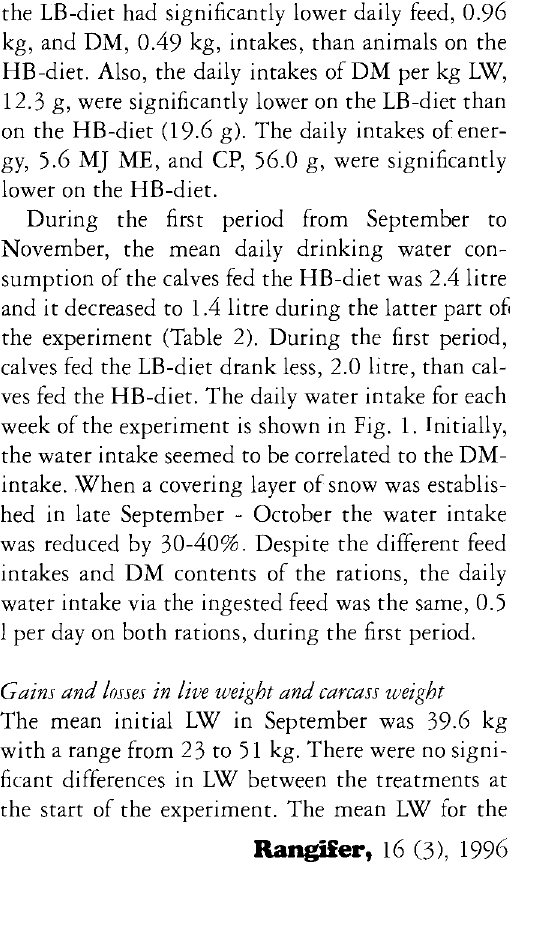
Fig. 1. Weekly means for the daily dry matter intake (DMI) and drinking water intake (WI) of reinde er calves fed diets with low, 30% (LB, — ), or high, 60% (HB, -), proportions of barley in the dry matter. The slaughter occasions are indicated by vertical lines.